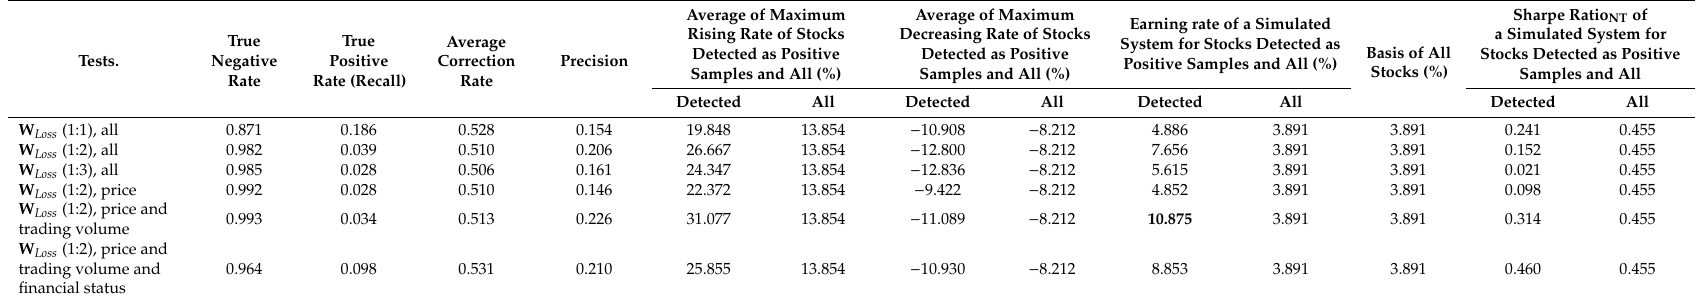
Table 6. Ranking-based stock classification with di ff erent W Loss values and di ff erent features (all: all features; price: price-related features; trading volume: trading volume feature; financial status: company financial status-related features).